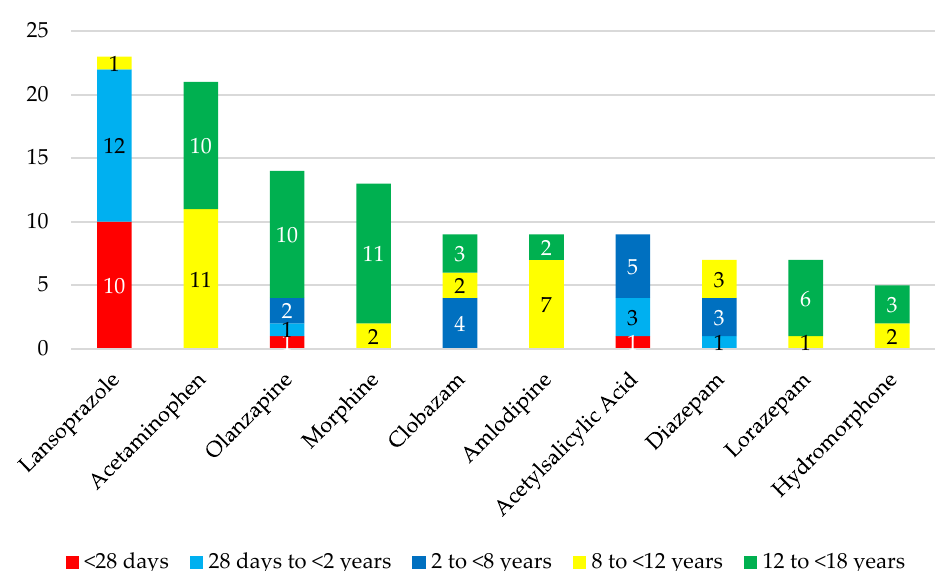
Figure 3. Ten most prescribed solid CDEA in the total population. Nearly half (N = 298 [49%]) of hospitalized children received at least one prescription for a CDEA, with a median of two CDEA per child (range, 1 to 10). This population received 74% (n = 4018) of all 5465 prescriptions and had a median of 11 prescriptions per child in their medical file (range, 1 to 41). Neonates and teenagers were the groups receiving the least CDEA, 0.9 and 0.8 prescriptions per child, respectively, when compared with others (8 to <12 years, 2.2; 2 to <8 years, 1.7; 28 days to <2 years, 1.2). More than half (N = 49 [65%]) of neonates receiving a CDEA were premature with a gestational age under 32 weeks. The characteristics of patients with at least one prescription for a CDEA are described in Table 4. Hospitalized children with one or more CDEA were overrepresented in multispecialty departments (17 vs. 13%), the rehabilitation centre (15 vs. 9%), the hematology–oncology department (14 vs. 8%), and in the pediatric ICU (12 vs. 7%) when compared with the total population. Table 4. Patients receiving at least one CDEA (N = 298). Age Group